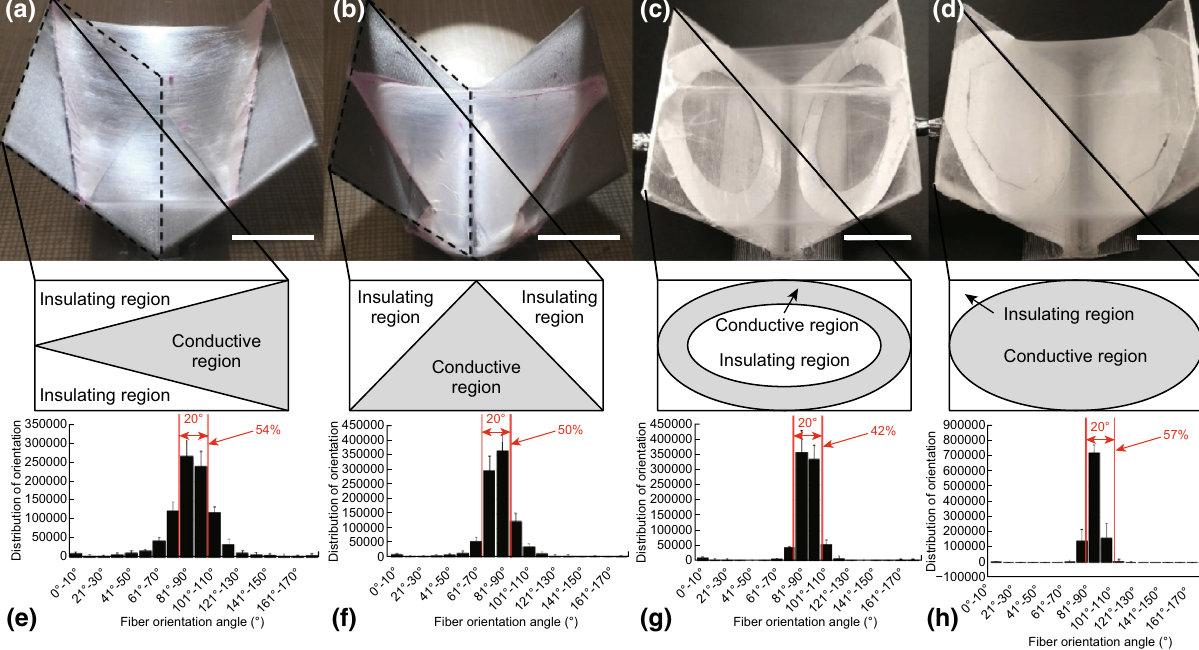
Fig. 7 a A pentahedral and b tetrahedral scaffold fabricated by specially designed collectors. c A columnar scaffold with a hollow structure and d a cylindrical scaffold. Scale bar = 10 mm. e – h The fiber alignment histograms for scaffolds 7a–7d, bevels formed a matrix of microgrids with a density of Using a four-bevel collector, a 20 mm 9 20 mm scaf- * 11%. The volumetric density of reticular fibers varies fold with a grid microstructure was obtained as shown in from 10 to 30% depending on the locations of the tissues as Fig. 8. Multi-axially aligned nanofibers assembled at the well as the age of person [13]. The special internal top section of the collector. Fibers connecting each pair of